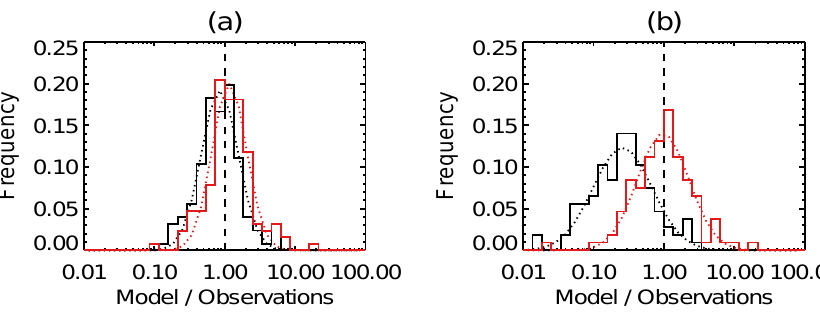
Fig. 3. Probability density functions of model to observed ratios of CCN concentration when carbonaceous combustion aerosol does not act as CCN (black line) and when carbonaceous aerosol does act as CCN (red line) for (a) clean conditions (simulated BC < 50ngm − 3 ), (b) polluted conditions (BC > 100ngm − 3 ). Dashed line indicates the model to observed ratio of 1. The dotted lines show Gaussian fits to the probability density